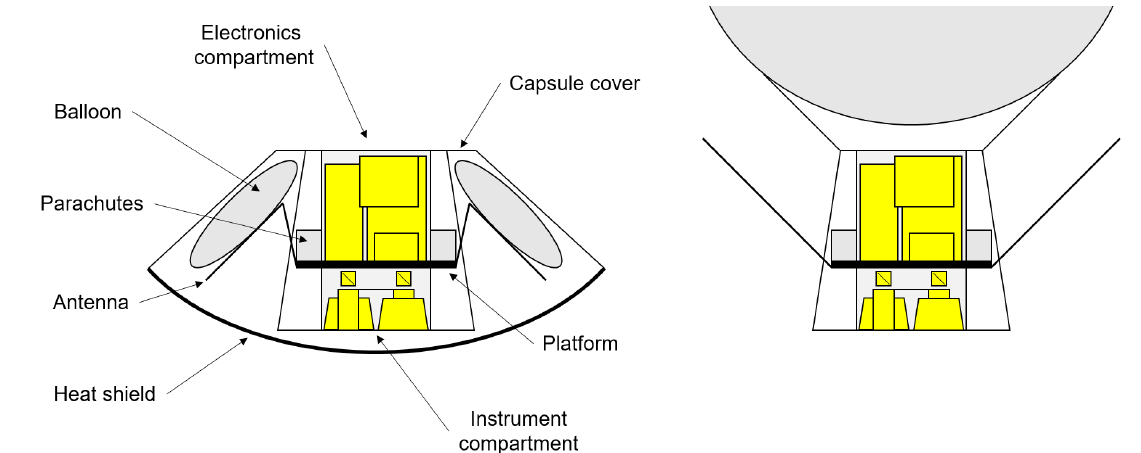
Figure 5. Conceptual design of the proposed Venus probe in stowed (left, during cruise and entry) and deployed (right, during operations in the atmosphere) configurations.